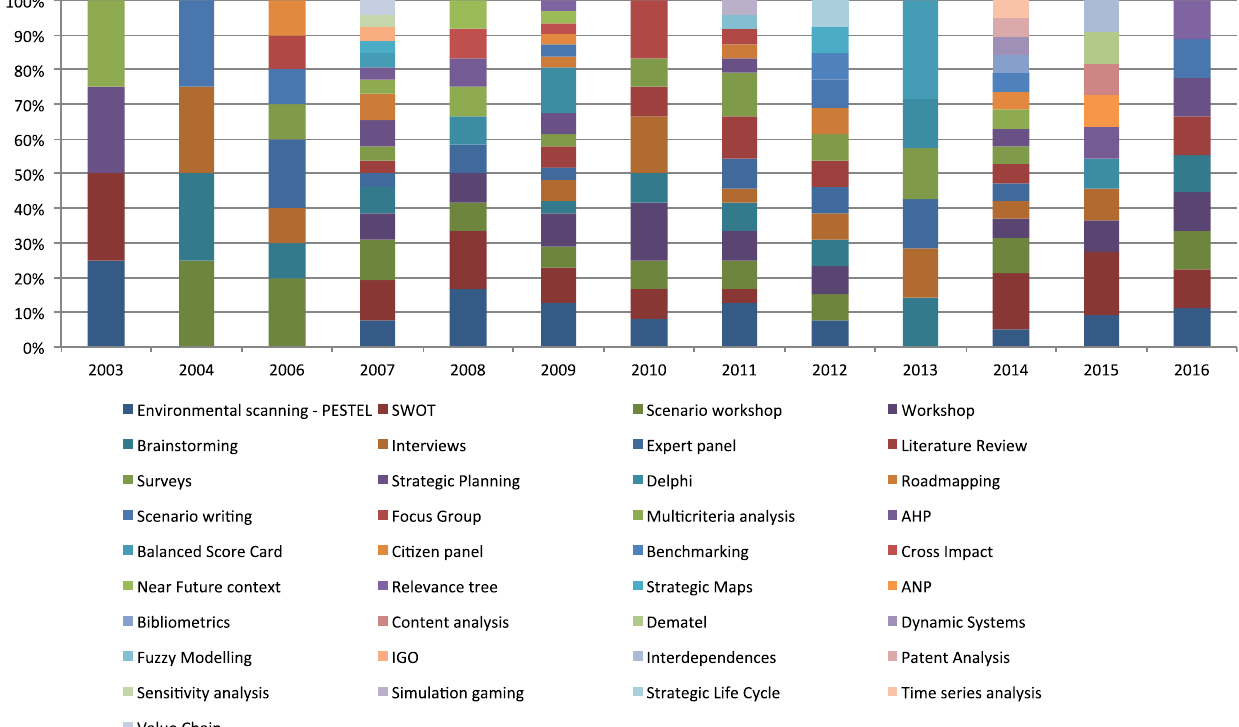
Fig. 5 Distribution of FTA methods per year